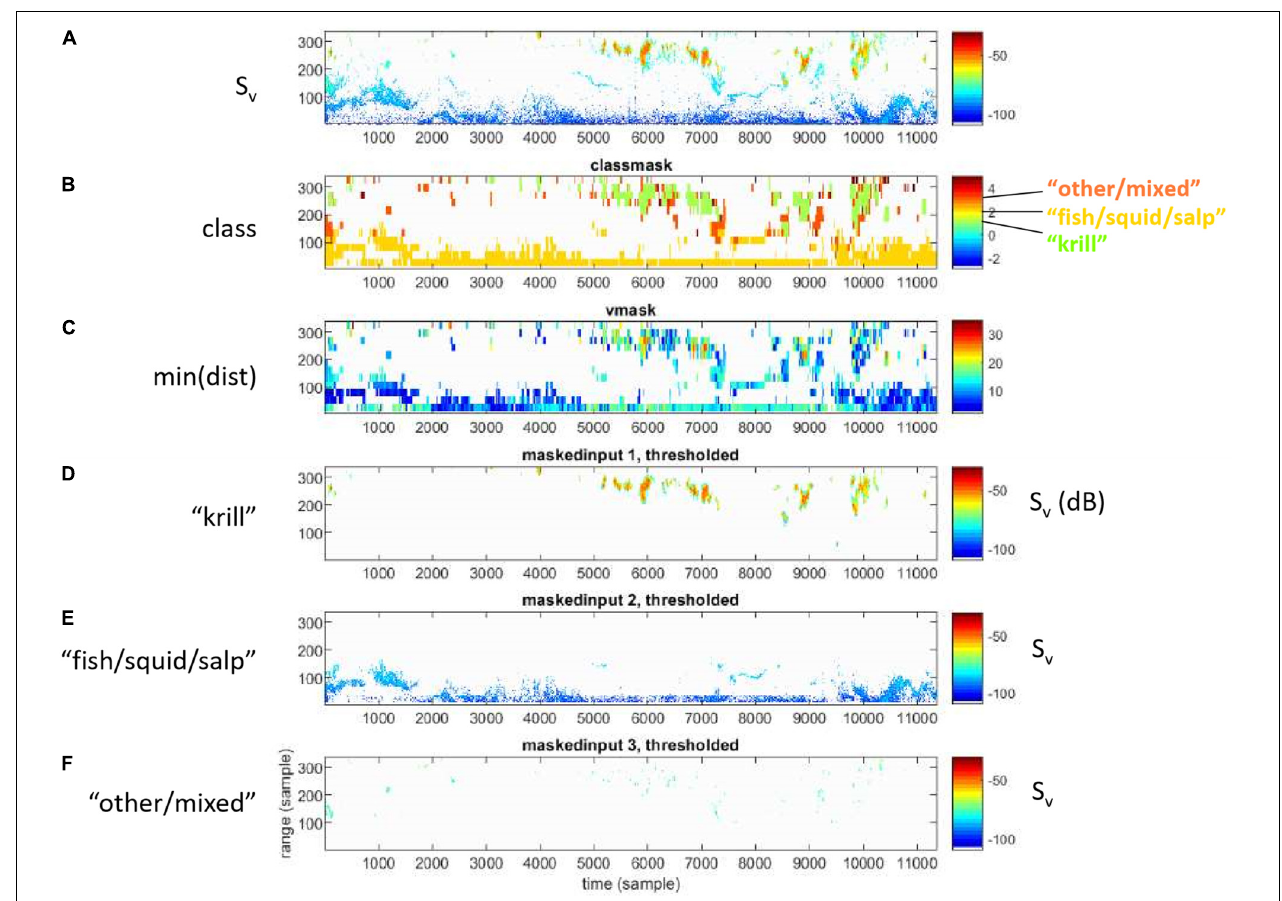
FIGURE 4 | (A) S v data, (B) assigned class, (C) minimum distance to class centroid, and S v of (D) krill, (E) fish/squid/salp, and (F) other/mixed classes.